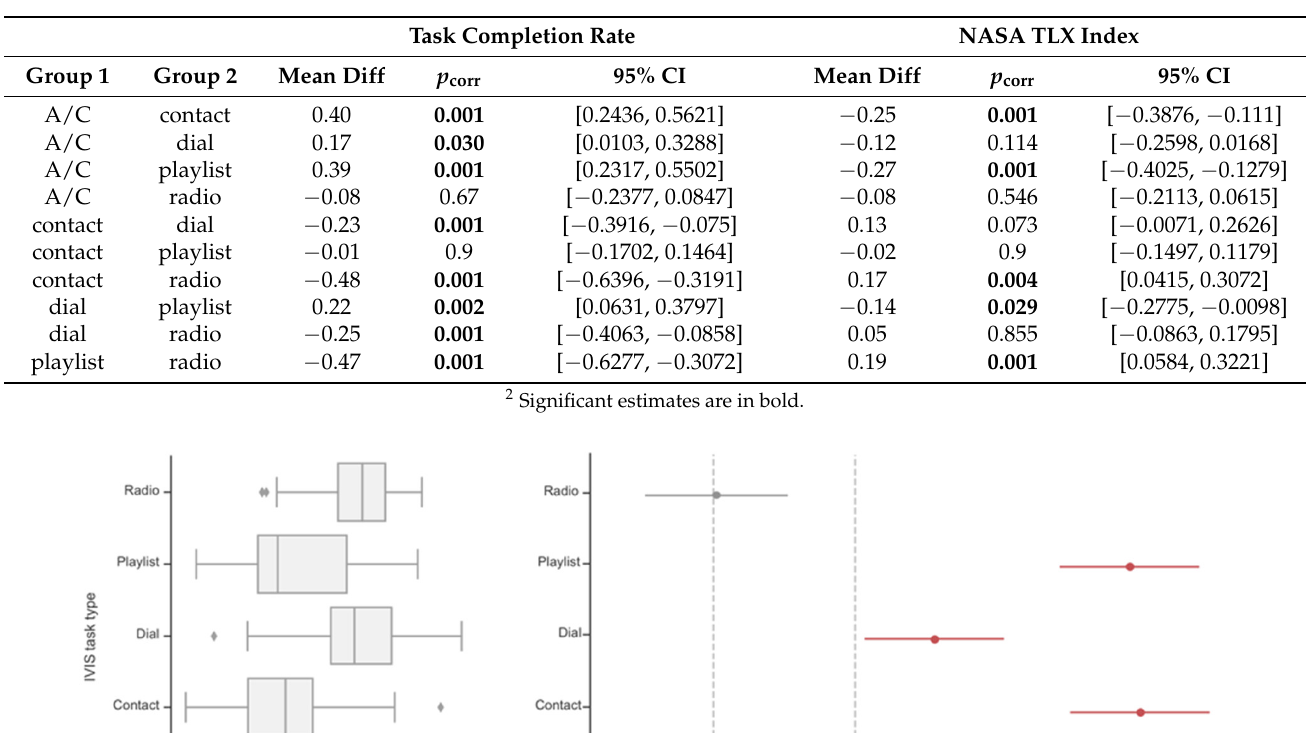
Table 4. Comparison of the mean workload scores for IVIS tasks (Tukey’s HSD) 2 . Left: objective workload measured by the task completion rate. Right: subjective workload measured by NASA TLX.